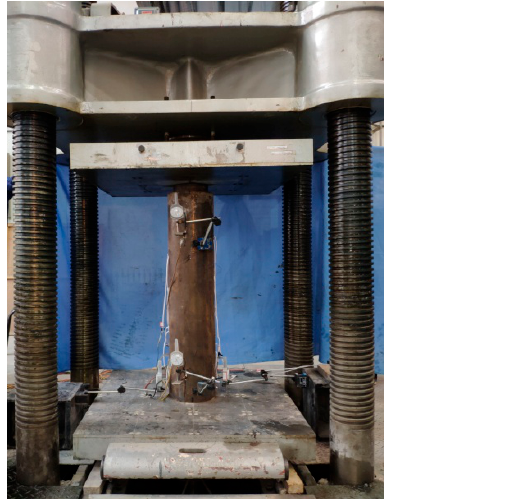
( e ) Figure 4. Location of strain gauge on the steel tube: ( a ) CFT-PAC-8; ( b ) CFT-PAC-7; ( c ) CFT-PAC-6; ( d ) CFT-PAC-5; ( e ) CFT-PAC-1~CFT-PAC-4, CFT-NC-1~CFT-NC-3. The critical bond stress and bond strength could be calculated by the following formulas: s s P DL τ π= (1) u u P DL τ π= (2) where τ s is the critical bond strength (MPa); τ u is the bond strength (MPa); P s is the critical load (N); P u is the ultimate load (N).